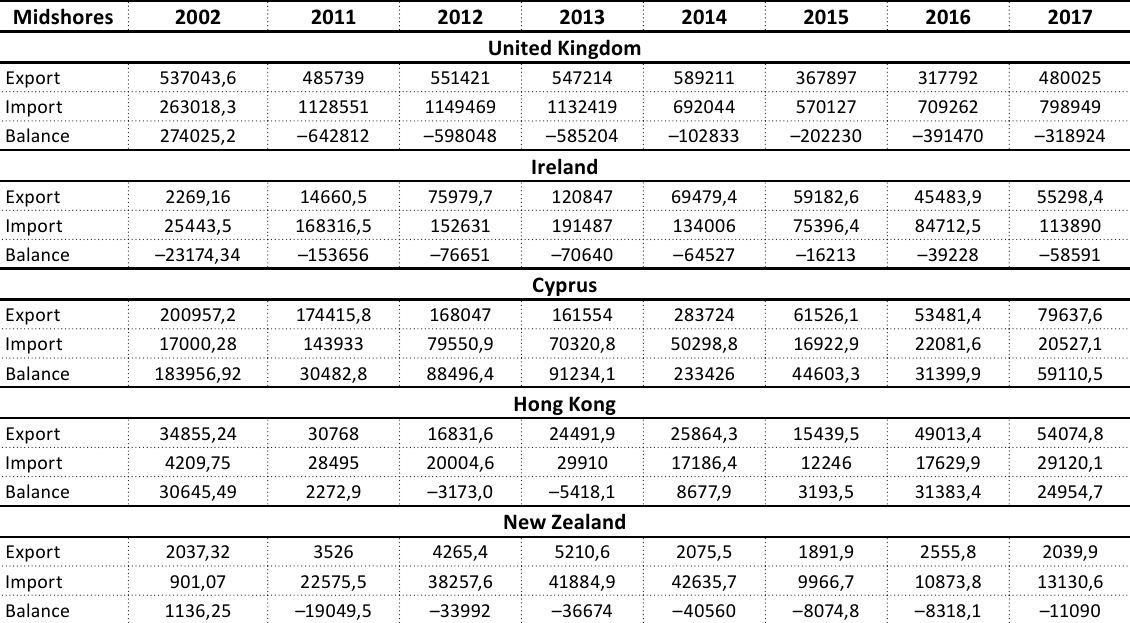
Table 3. Dynamics of Ukrainian international trade indicators with midshores during 2002–2017, USD thsd. Source: Data from the State Statistics Committee of Ukraine, World